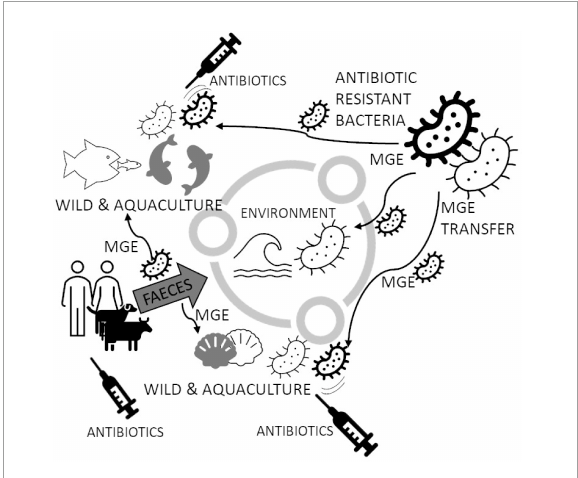
FIGURE1 Circulating Mobile Genetic Elements (MGE) may increase Antibiotic Resistant (AR) marine bacterial species in the marine environment. Bacteria in the marine environment may spread resistance genes to other species, especially when antibiotics appear (like in fish aquacultures and bivalves’ larval hatcheries). The spread of MGE generates new strains of bacteria capable of successfully breaking out and becoming resistant to popular antibiotics. Antibiotics are delivered to water also with feces from coastlines, which are usually densely populated. The